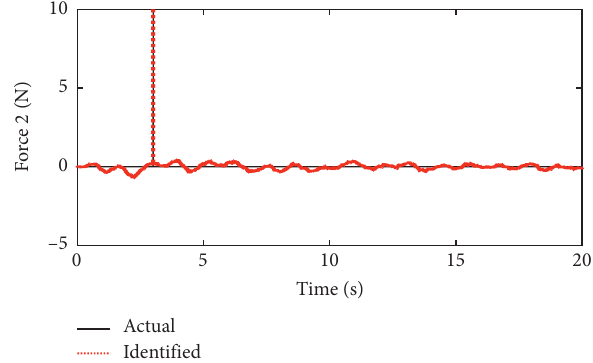
Figure 5: Identification of external load u